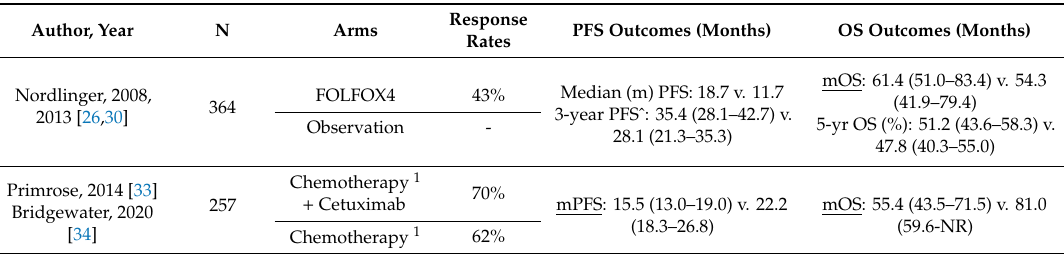
Table 2. Peri-operative chemotherapy for resectable disease. PFS, progression-free survival, OS, overall survival, FOLFOX4, Fluorouracil, Leucovorin,